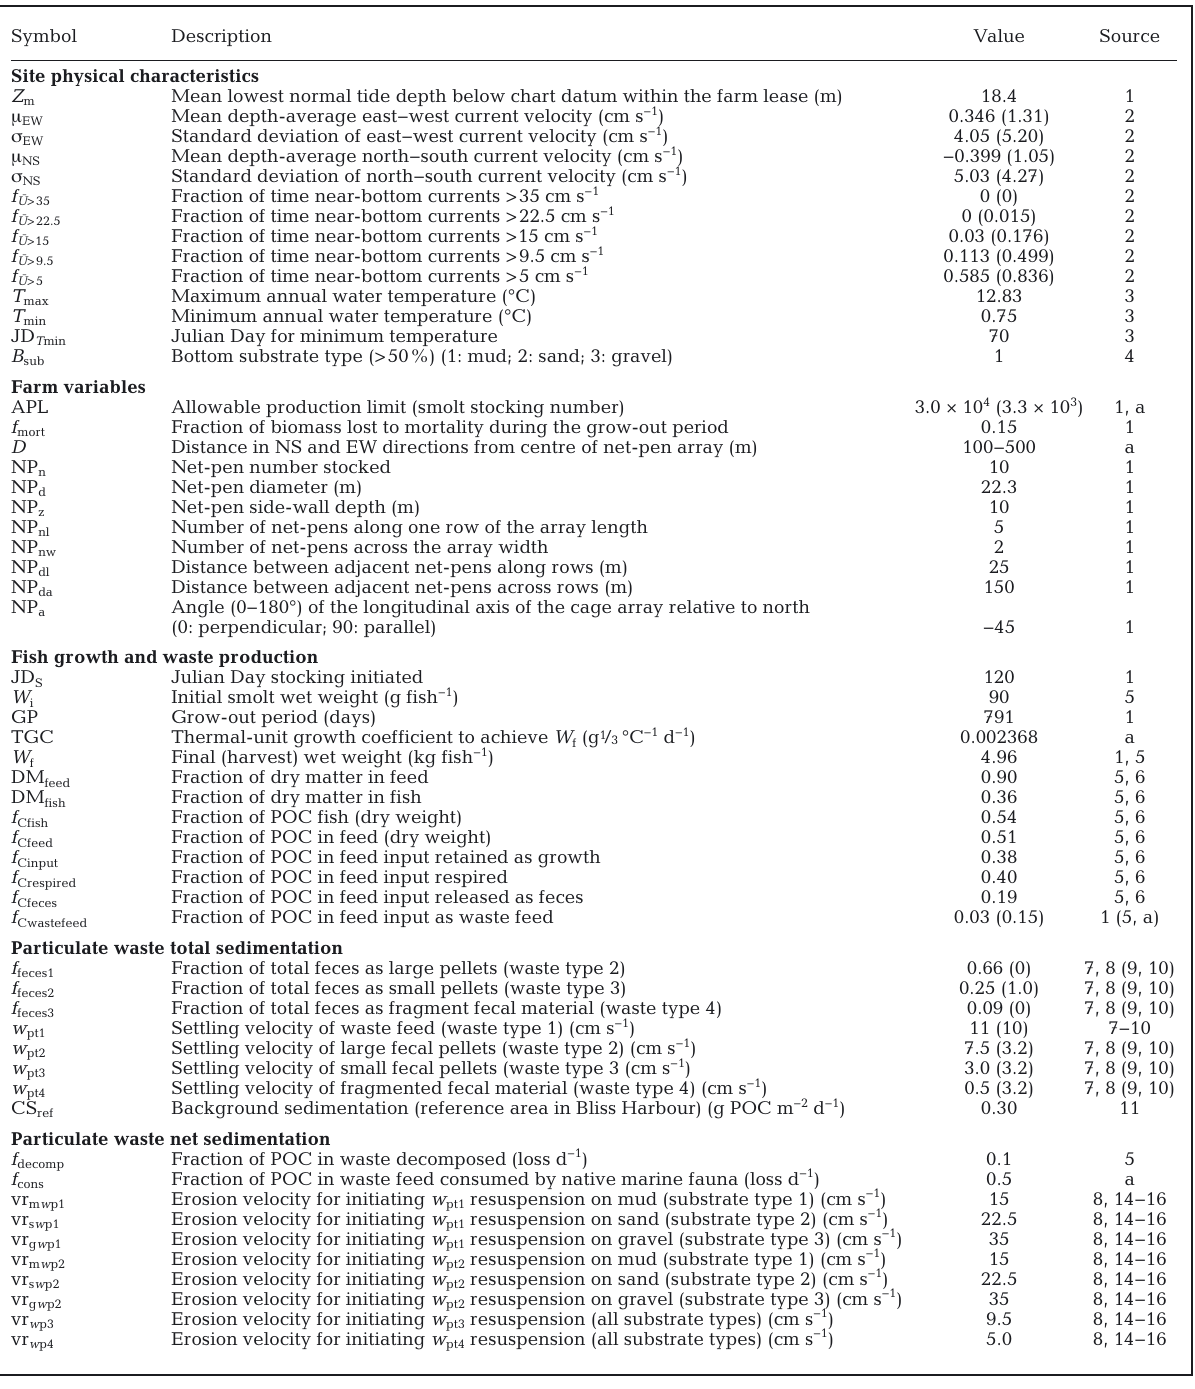
Table 1. Variables used to calculate salmon growth, particulate waste production, dispersion and total and net sedimentation for 2 Atlantic salmon farms (A and B) in Bliss Harbour, Bay of Fundy (Fig. 1). POC: particulate organic carbon. Data sources: (1) Chang et al. (2014a); (2) parameters for current statistics for time periods A (CM383) (June−August 2009) and B (CM409) (September−November 2009) described in Table 2; (3) Robinson (2022) and Fig. 3; (4) Wu et al. (2014); (5) Strain & Hargrave (2005); (6) Wang et al. (2012, 2013); (7) Bannister et al. (2016); (8) Carvajalino-Fernández et al. (2020); (9) Cromey et al. (2002a); (10) Stucchi et al. (2005); (11) Hargrave (1994); (12) Callier et al. (2018); (13) Riera et al. (2017); (14) Sutherland et al. (2006); (15) Law et al. (2014, 2016); (16) Adams et al. (2020). Numbers in parentheses represent alternative values for time periods A and B (Table 2). a: assumed or calculated